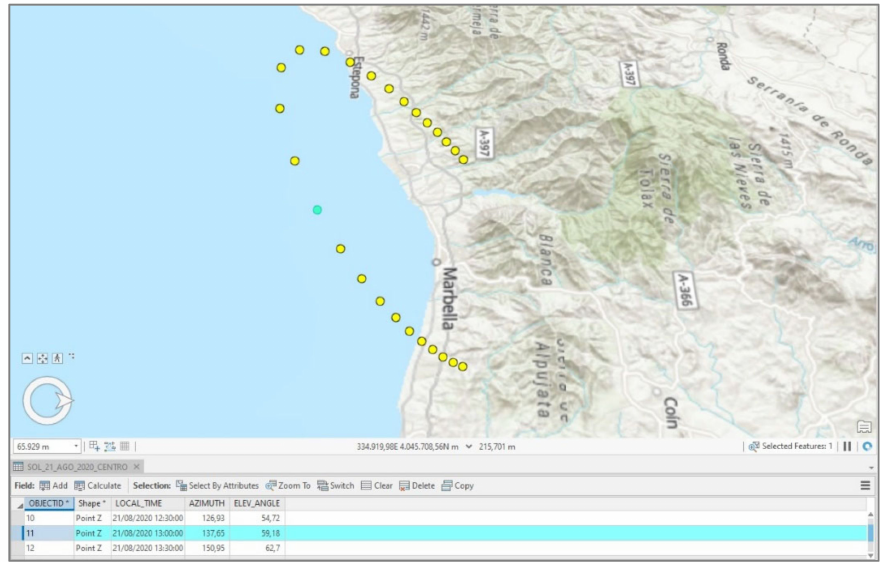
Figure 5. Sample of the solar position model in the field of study.